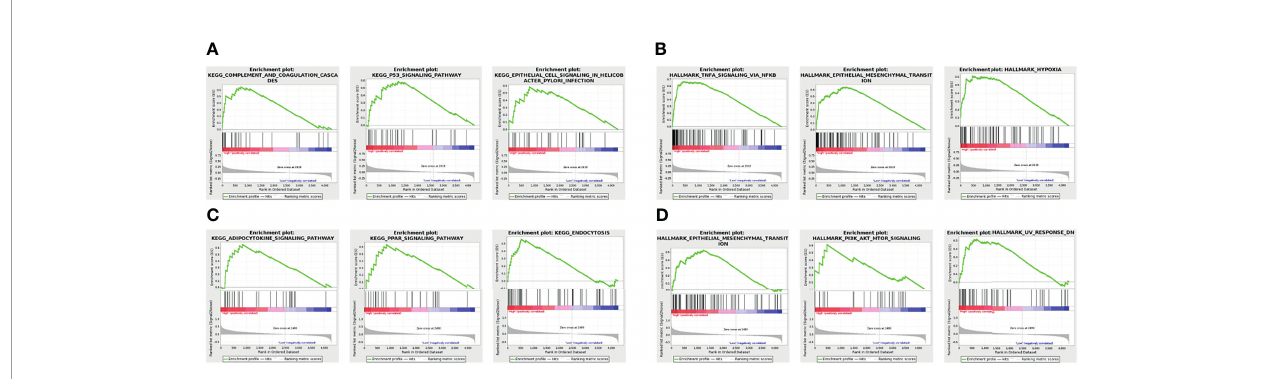
FIGURE 7 | Single-gene functional enrichment analysis. (A) Results of ERRFI1 enrichment analysis in the KEGG pathway; (B) Results of ERRFI1 enrichment analysis in the HALLMARK pathway; (C) Results of ROR1 enrichment analysis in the KEGG pathway; (D) Results of ROR1 enrichment analysis in the